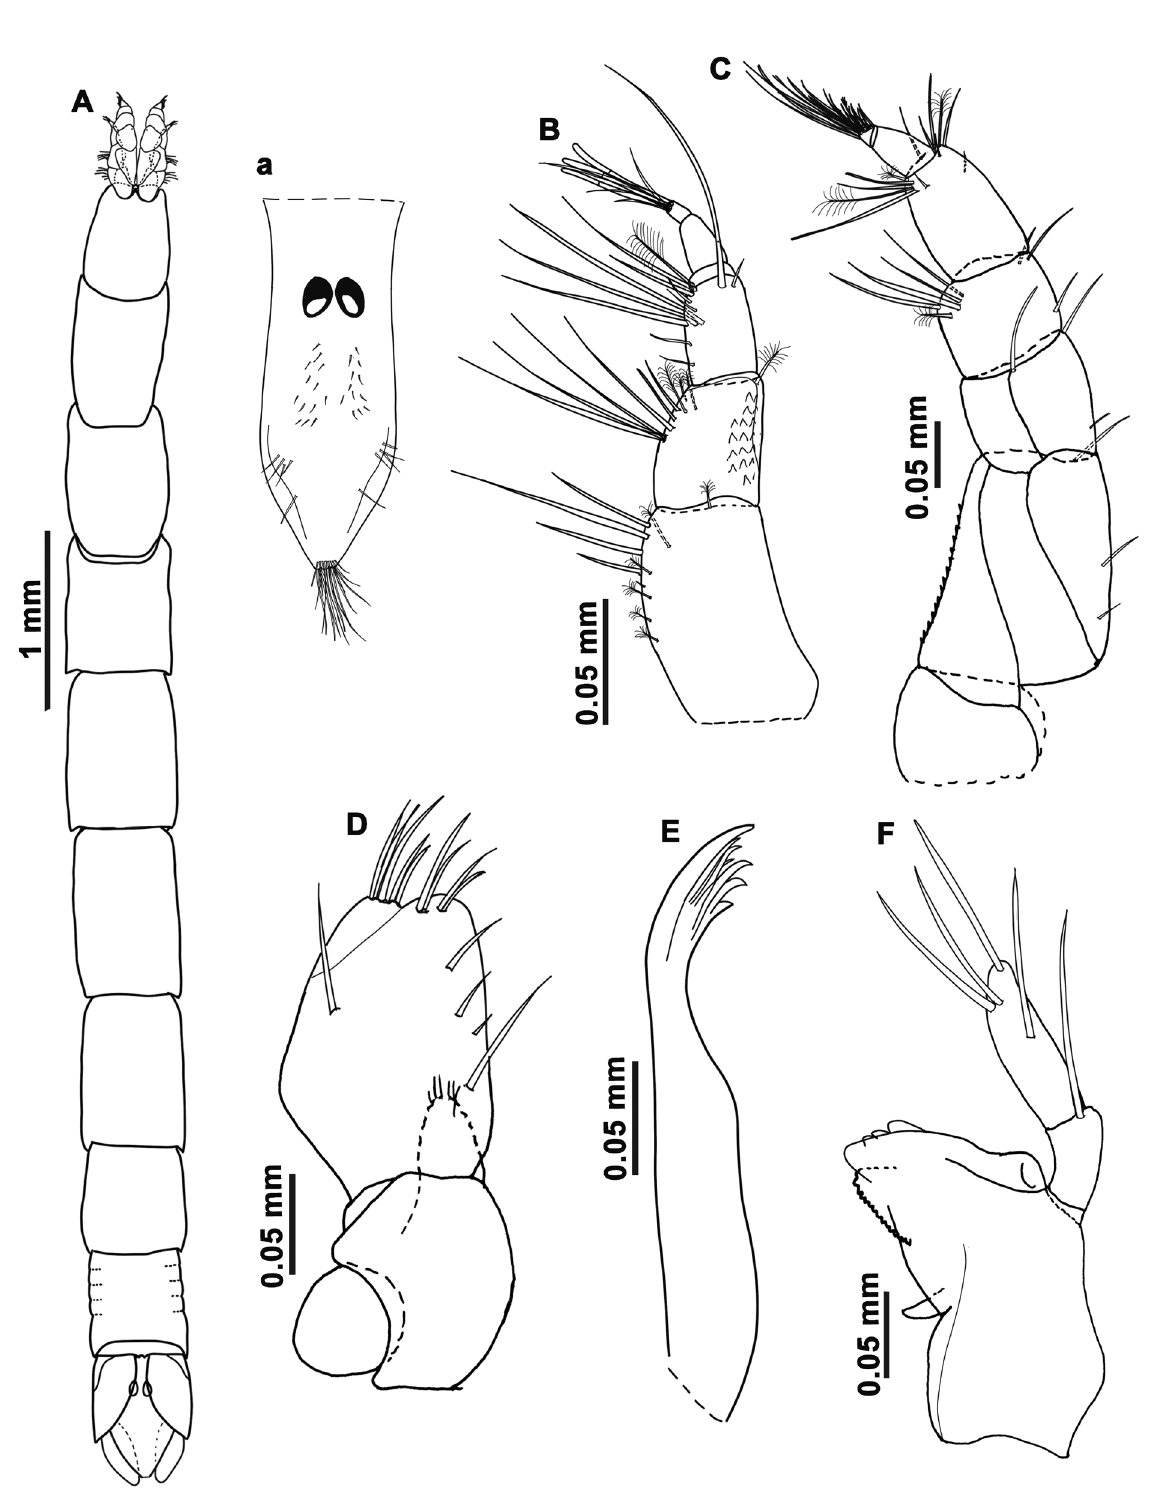
Fig. 5. Cortezura caeca sp. nov., holotype, ♀, 7.1 mm, Oaxaca, Huatulco, Jicaral Beach (UMAR-PERA 534). A . Habitus and telson (a). B . Antennule. C . Antenna. D . Maxilliped. E . Maxilla. F .